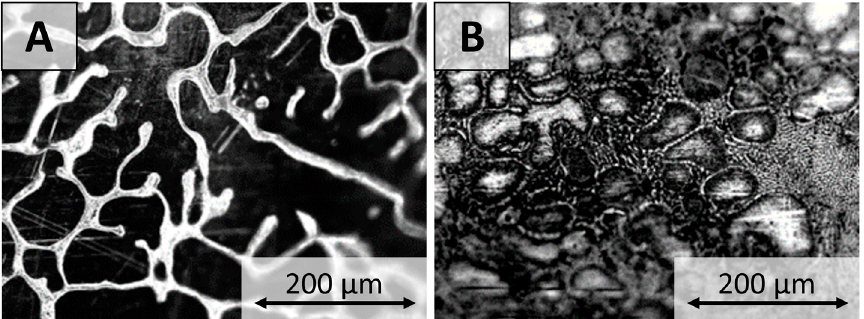
Figure 9. Comparison of microstructure of solidified Sn-10%wt.Pb alloy: ( A ) solidified alloy without magnetic field; ( B ) Solidified alloy under DC (B = 0.4 T) and pulsed (B = 0.5 T) magnetic field